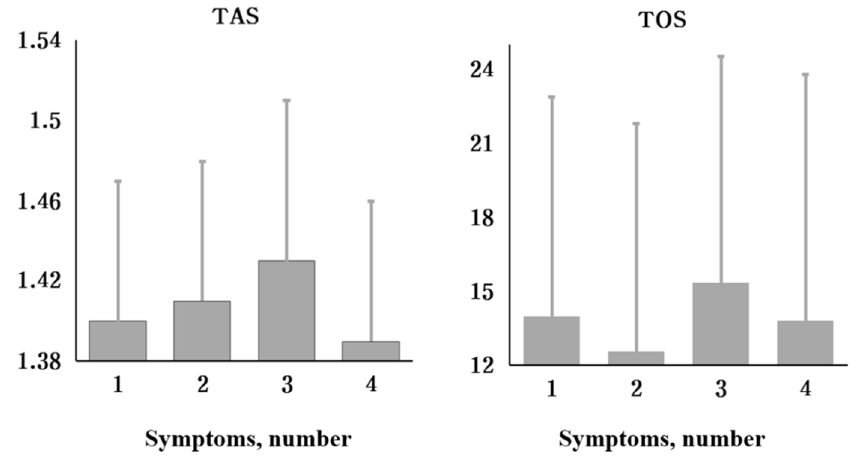
Figure 1. Mean total antioxidant status (TAS) total oxidant status (TOS) among groups classified according to number of symptoms. Table 3. TAS and TOS (mean ± SD) among groups classified according to number of symptoms. Variables